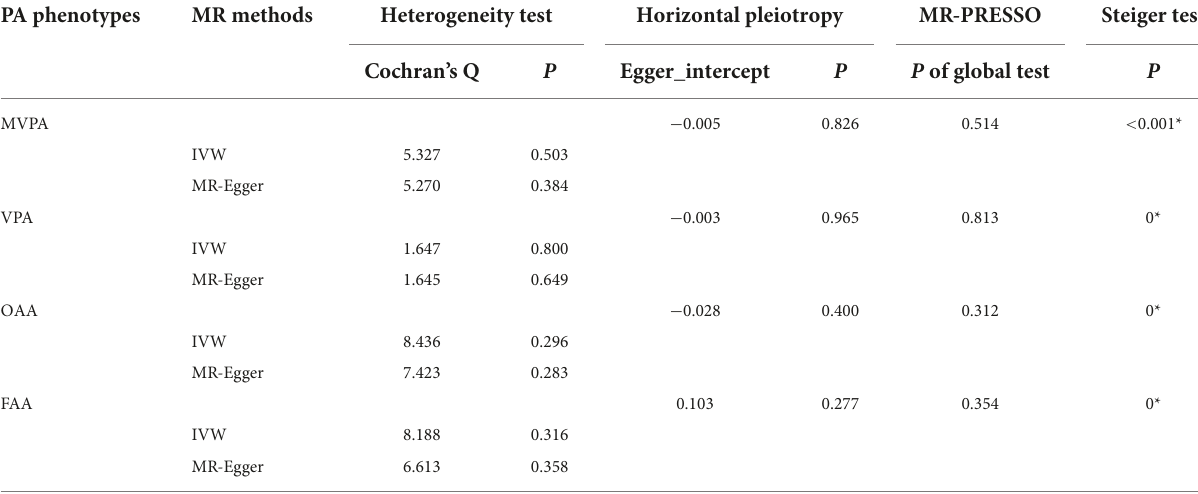
TABLE 2 Sensitivity test of the mendelian randomization analysis between physical activity phenotypes and amyotrophic lateral sclerosis. PA